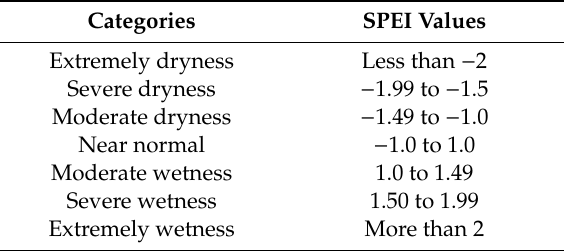
Table 1. Categorization of dryness / wetness grade by the